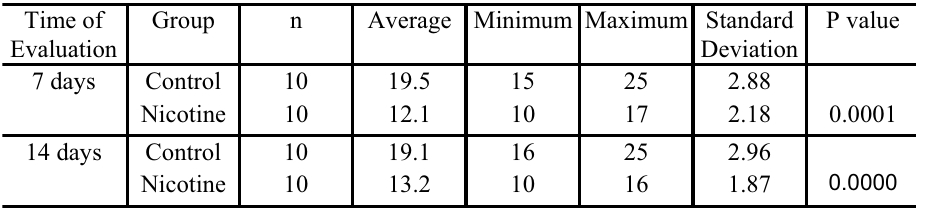
FIGURE 3 – Results of the collagen III evaluation, averages and standard TABLE 1- Result of the average number of fibroblasts per field in scars from the two groups at both evaluations